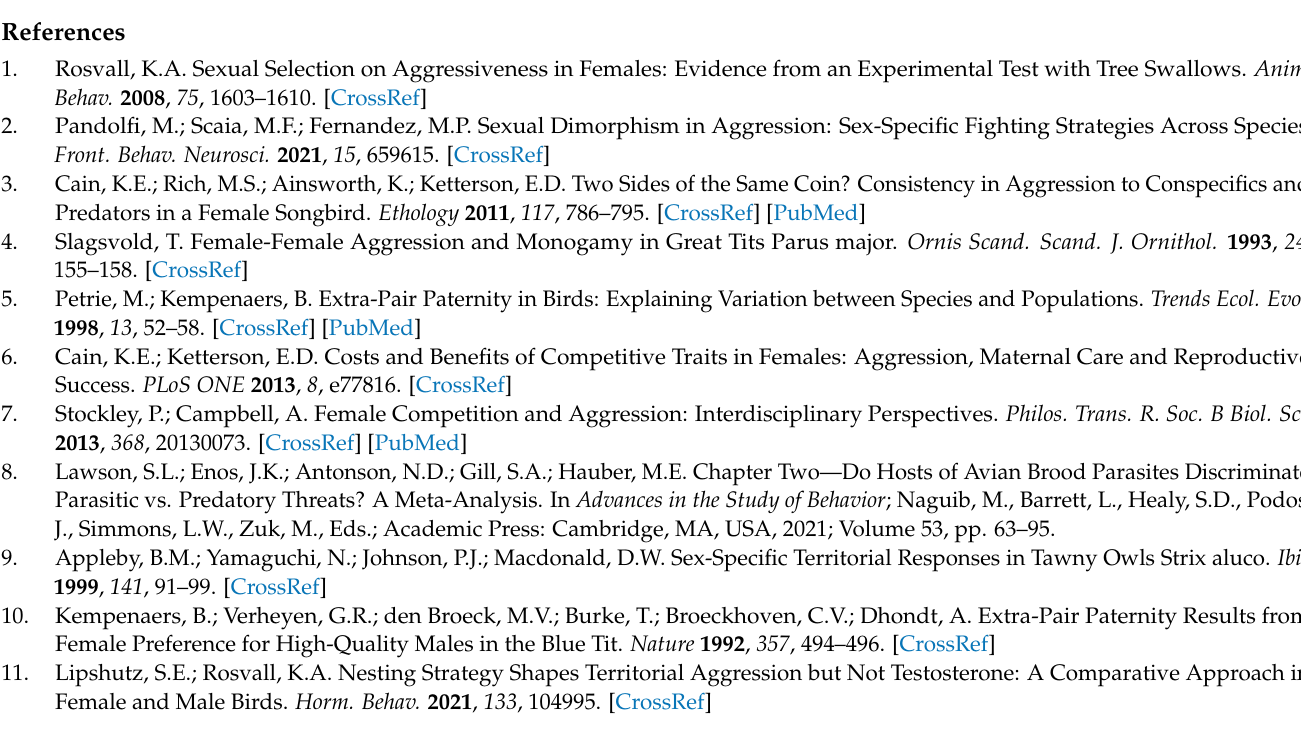
† Variables: The number of pecks (Pecks), time on the decoy (Time on decoy), number of calls (Calls), number of song phrases (Song), minimum distance to the decoy (Minimum distance), time in front of the nest-box entrance (Time in entrance), the time in the nest box (Time nest box), the number of times perching on the decoy (# on decoy) and the number of times entering the nest box (# in nest